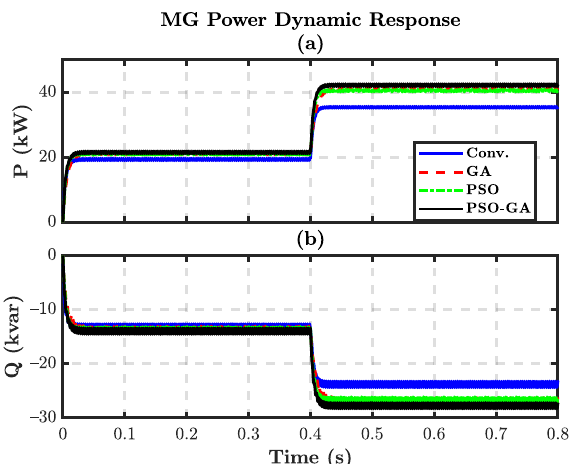
Figure 24. MG active and reactive power under nonlinear load changes: ( a ) active power; ( b ) reac- tive power.